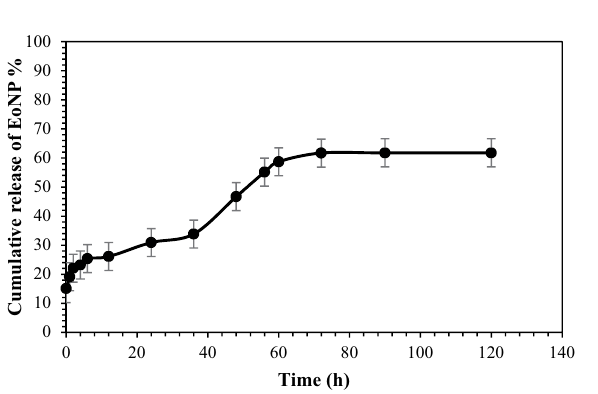
Figure 6. In vitro release profiles of H . pineodora essential oil from chitosan nanoparticles prepared in phosphate buffer saline pH